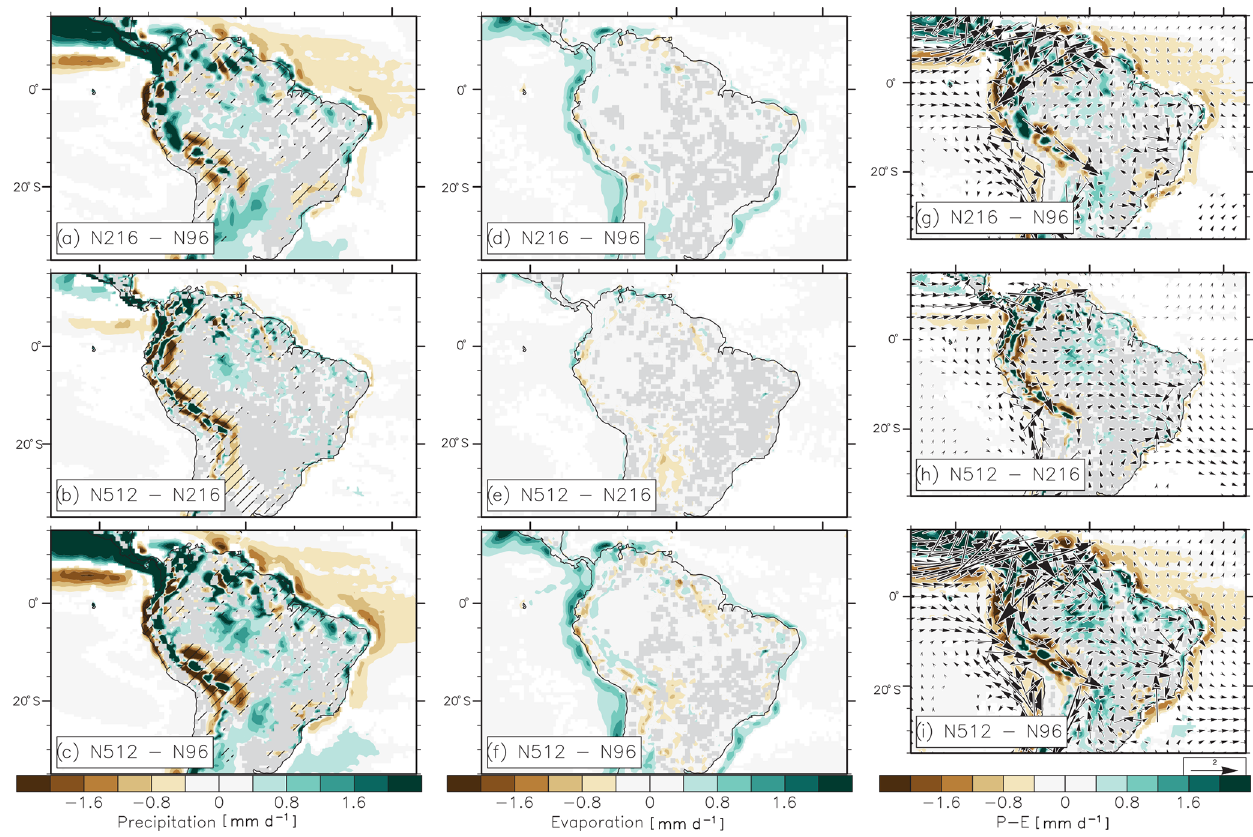
Figure 2. Ensemble-mean (a) N216–N96, (b) N512–N216, and (c) N512–N96 differences in mean annual precipitation (mmd − 1 ). (d, e, f) Same as (a) , (b) , and (c) but for evaporation (mmd − 1 ). (g, h, i) Same as (a) , (b) , and (c) but for the moisture flux convergence ( P − E ; mmd − 1 ; colours) and the 850hPa wind (ms − 1 ; vectors). For precipitation (i.e. a–c ) stippling indicates that the mean bias is reduced at the higher rather than at the lower horizontal resolution. Differences are shown when significantly different to zero according to a Student’s t test and a 95% confidence